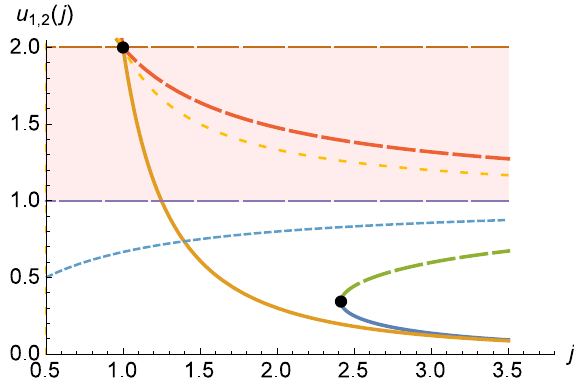
Figure 3. Roots u 1,2 as functions of initial specific momentum (angular momentum per mass unit) j . Dotted lines depict u ± . Pink zone is the ergosphere. 3